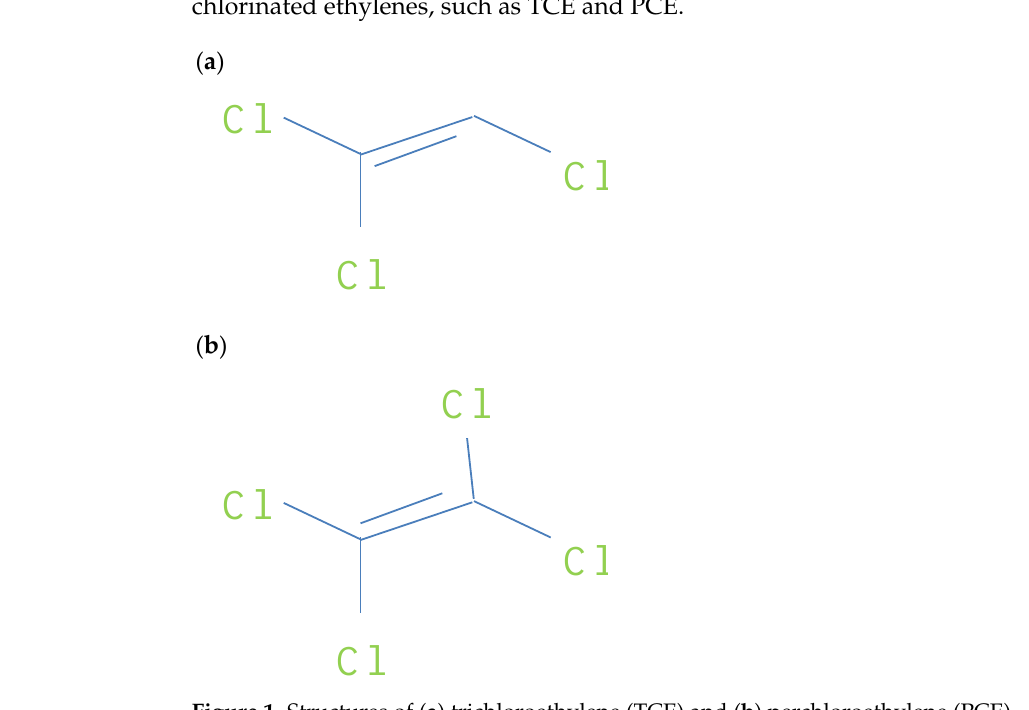
Figure 1. Structures of ( a ) trichloroethylene (TCE) and ( b ) perchloroethylene (PCE). The densities of TCE and PCE are 1.46 g cm −3 and 1.62 g cm −3 , respectively [4], and